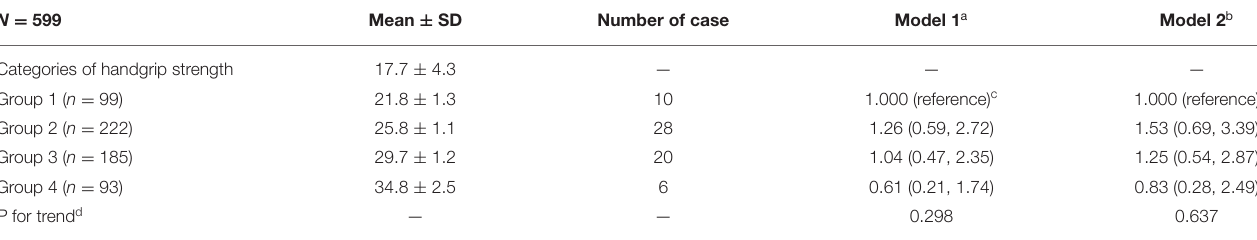
TABLE 2 | Adjusted odds ratios (95% confidence interval) of associations of baseline handgrip strength with depressive symptoms (SDS follow-up